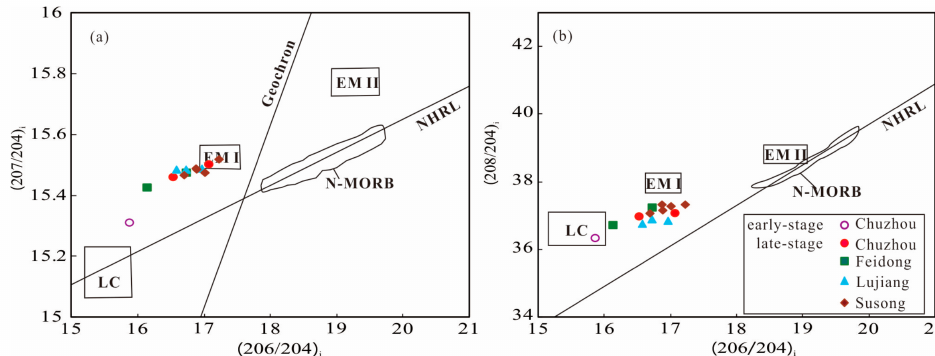
Figure 7. Plots of initial Pb isotopic ratios for volcanic rocks of the Xileng Formation: ( a ) 207 Pb/ 204 Pb versus 206 Pb/ 204 Pb; ( b ) 208 Pb/ 204 Pb versus 206 Pb/ 204 Pb. LC: lower crust; EM: enriched mantle; N-MORB: normal mid-ocean ridge basalt; NHRL: northern hemisphere reference